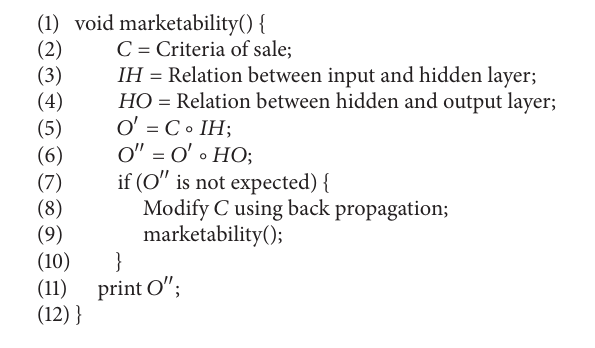
Algorithm 2: Architecture of IF neurons in